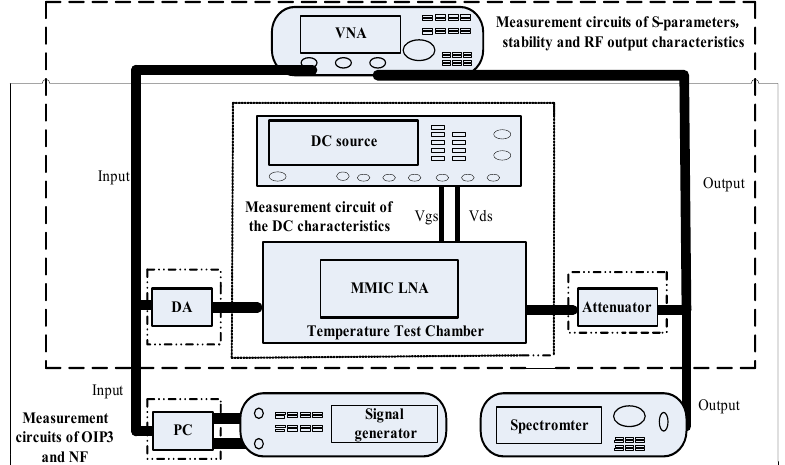
Figure 3. Measurement circuits.